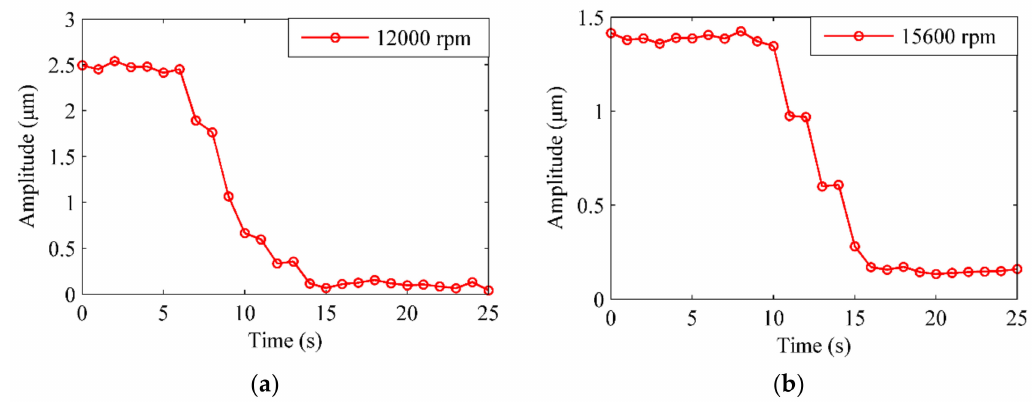
Figure 12. Balancing results at: ( a ) 12,000 rpm; and ( b ) 15,600